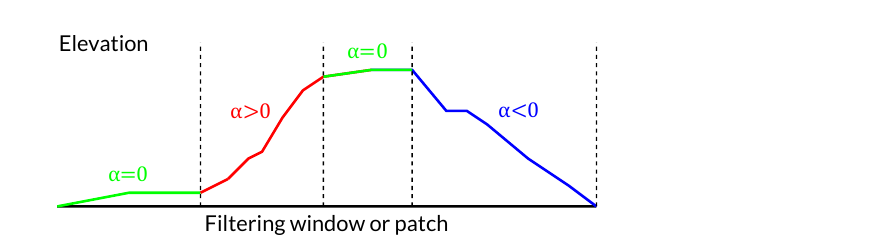
Figure 5. Example of filtering problem where a variety of slopes ( α ) is present in the same patch.